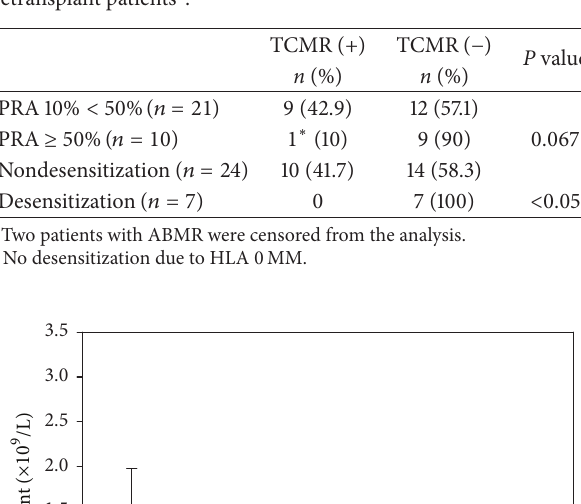
Table 2: Impact of desensitization on incidence of TCMR in retransplant patients # .